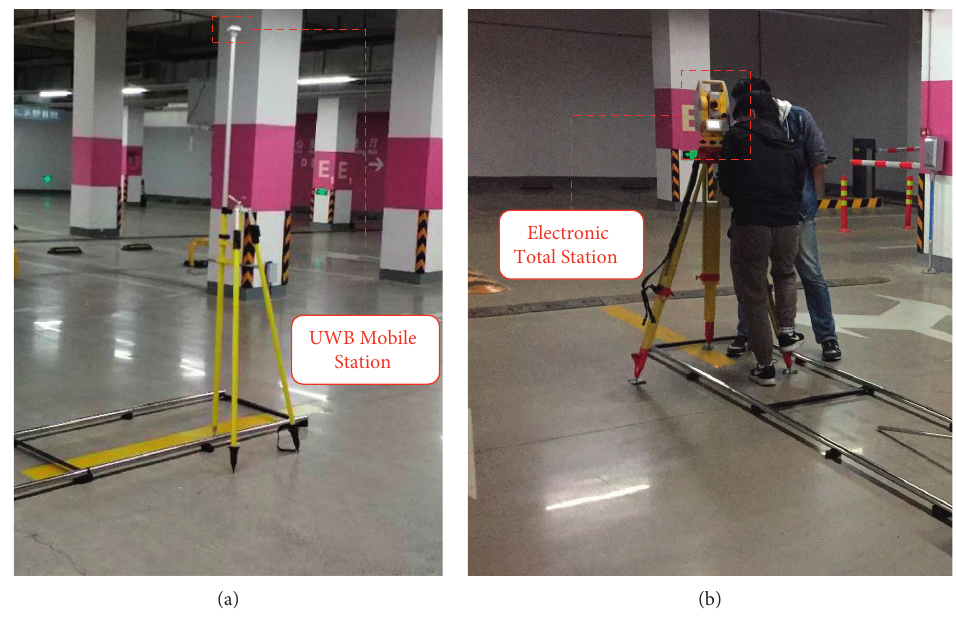
Figure 6: A tripod with MS and an electronic total